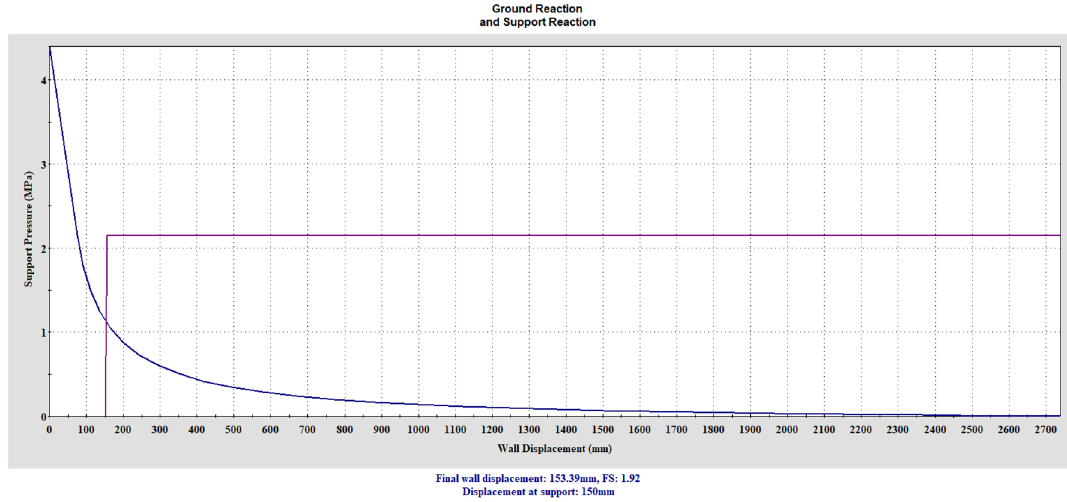
Figure 14. Outer lining ground and support reaction